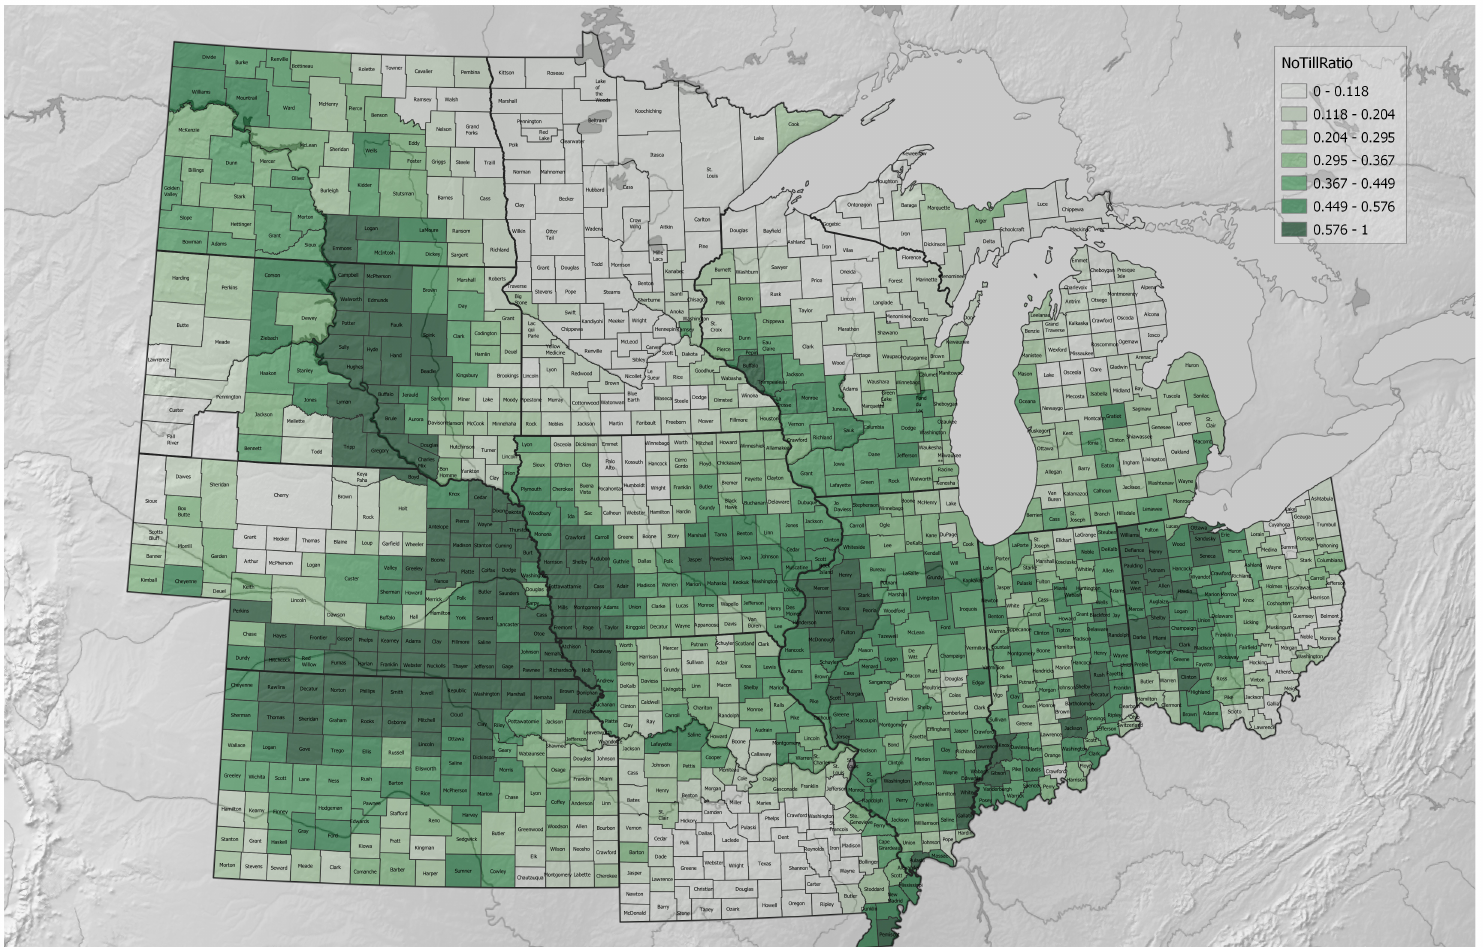
Figure A6. Fraction of farms practicing no-till, by county, 2017. Values were all rescaled through dividing by the largest value present for any of the counties included here (0.689 in Nuckolls County, Nebraska), as this transformation was applied to the variable data as they were placed into the index expression. Methods for NoTillRatio are described in the article main text and Supplementary Materials. USDA 2017 Census of Agriculture data [52] were